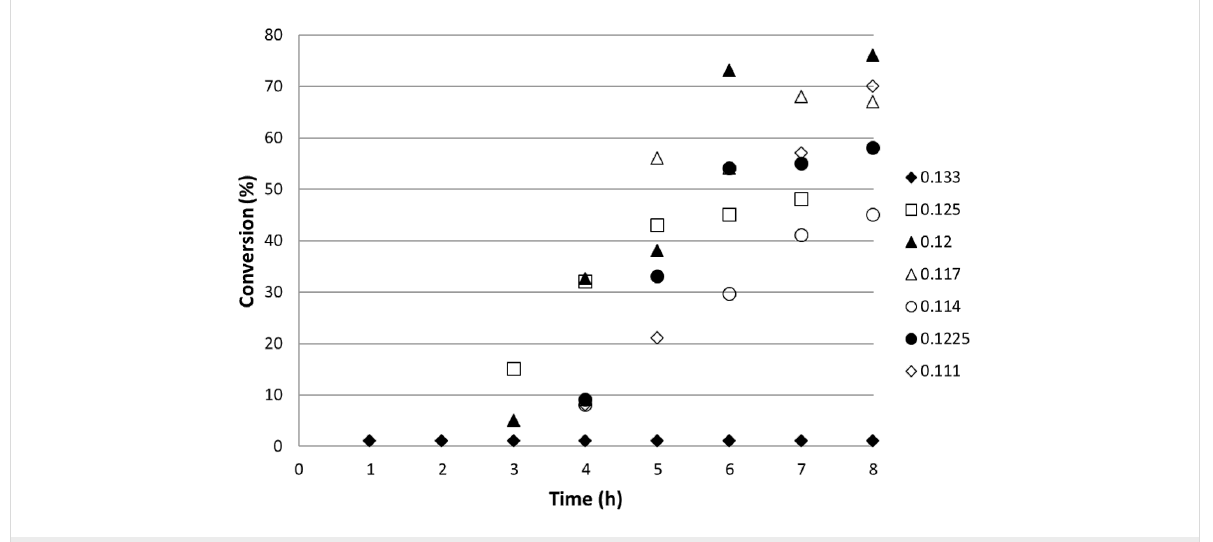
Figure 4: Total conversion of 4-iodoanisole at 155 °C and 200 bar as a function of reactor run time for different combined flow rates and therefore residence times. The values of the total flow rates given in the legend are mL min − 1 .